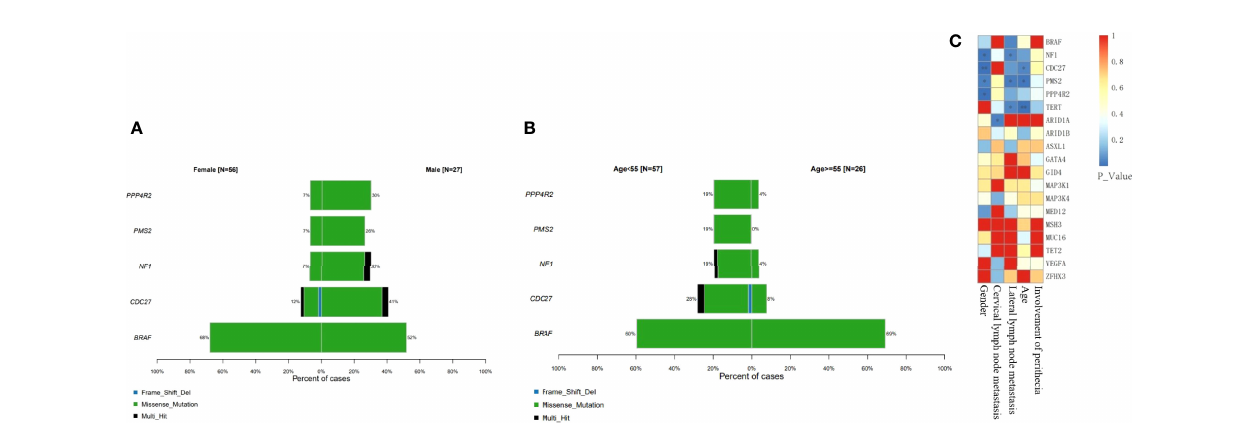
FIGURE 5 | Classi fi cation of driver mechanisms and clinical relevance. BRAF gene mutations always occur in female patients and in patients over 55 years of age (P > 0.05). Mutations of NF1, PMS2 and TERT were all related to a high rate of lateral cervical lymph node metastasis. (A) Proportion of different gene mutations in different gender groups. (B) Proportion of different gene mutations age groups. (C) Correlation between single mutant gene clinical manifestation (*P<0.05;